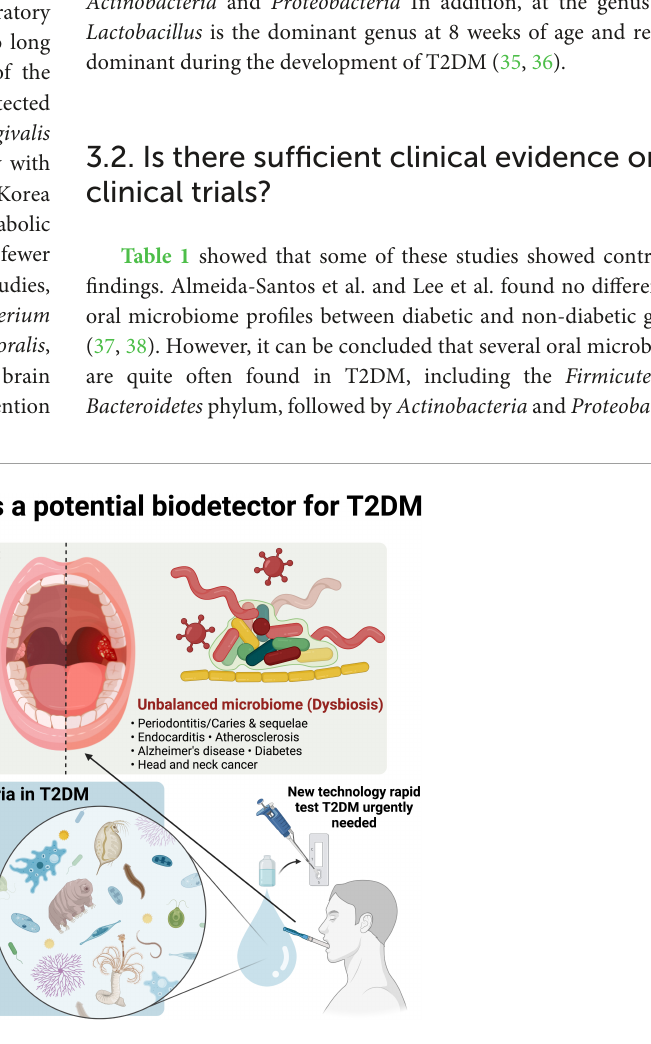
FIGURE1 Salivary microbiome as a potential biodetector for type 2 diabetes mellitus (T2DM). Created with BioRender.com premium license by Fahrul